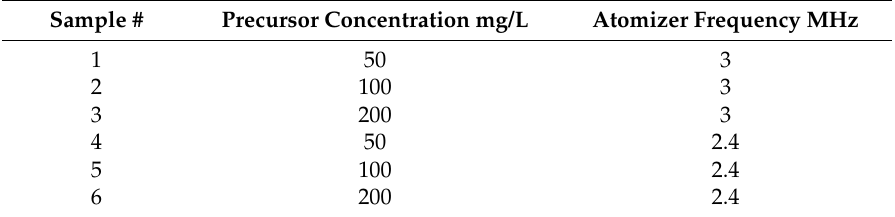
Table 1. Parameters for the first